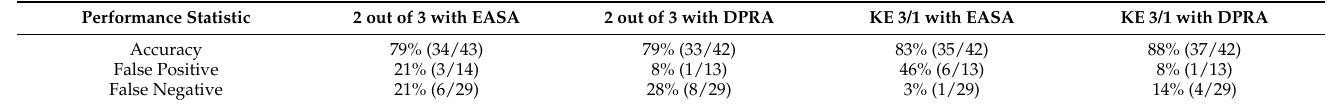
Table 3. Performance of defined approaches with EASA or DPRA with LLNA as the